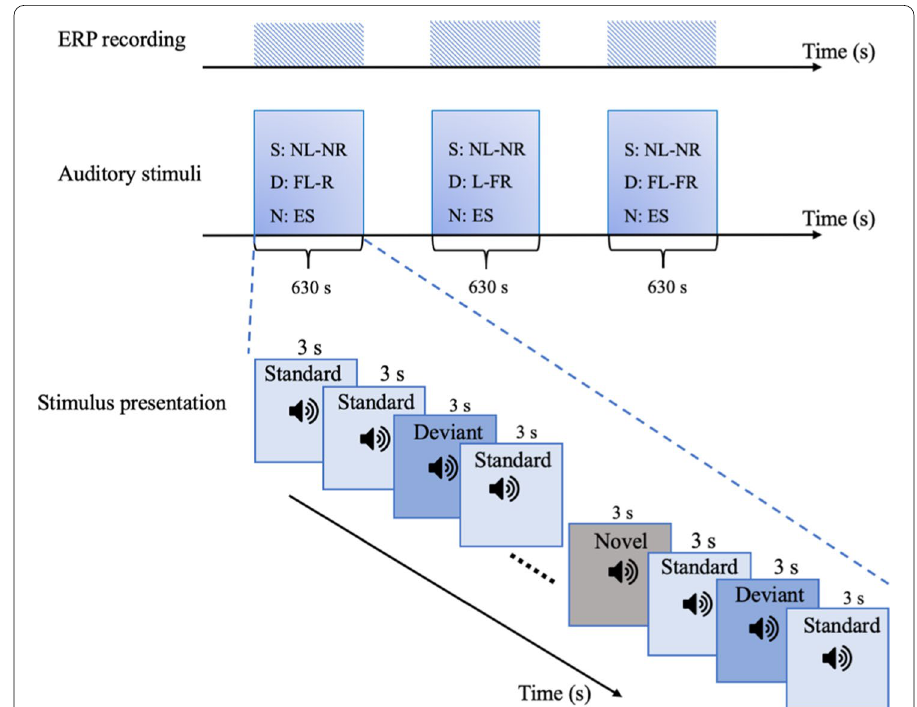
Fig. 2 ERP experimental design. S standard stimuli, D deviant stimuli, N novel stimuli, NL-NR unfiltered stimuli in both channels, FL-R filtered stimuli in the left channel and unfiltered stimuli in the right channel, L-FR unfiltered stimuli in the left channel and filtered in the right channel, FL-FR filtered stimuli in both channels, ES environmental sounds